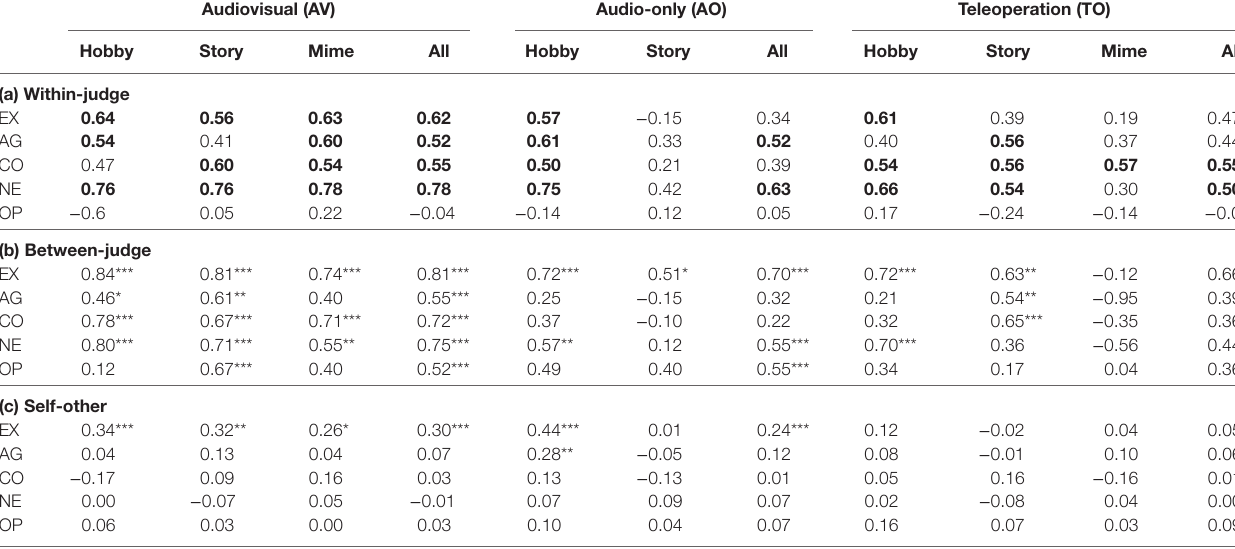
TaBle 2 | analysis of personality judgments across 3 communication conditions and 3 tasks.